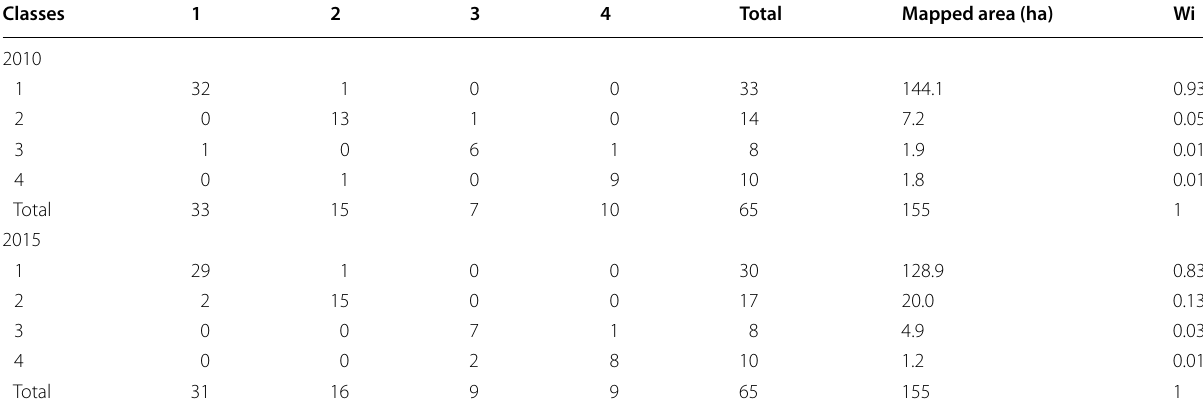
Classes 1 cropland, 2 vegetation, 3 grassland, 4 settlement. Rows and columns represent map and reference categories respectively